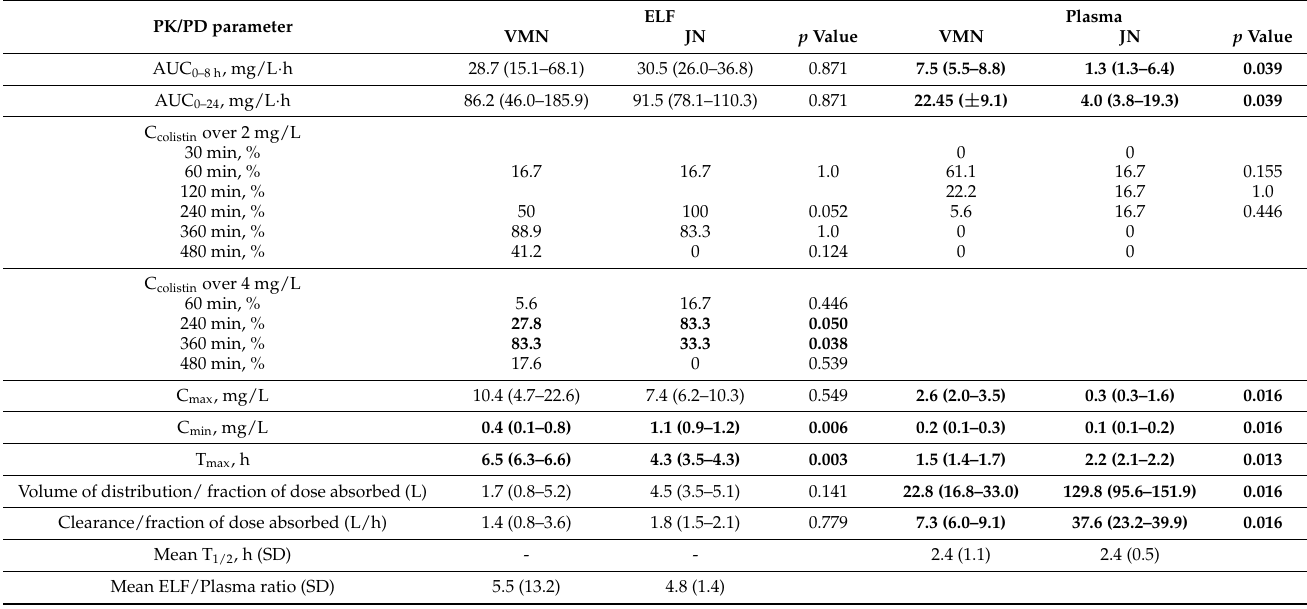
Table 2. Pharmacokinetic/pharmacodynamic (PK/PD) parameters in epithelial lining fluid (ELF) and in plasma after inhalation of 2 million international units of colistimethate sodium via jet nebulizer (JN) or vibrating mesh nebulizer (VMN). Values are expressed as frequencies or medians and interquartile ranges, unless otherwise specified. Comparisons with statistically significant differences are depicted in